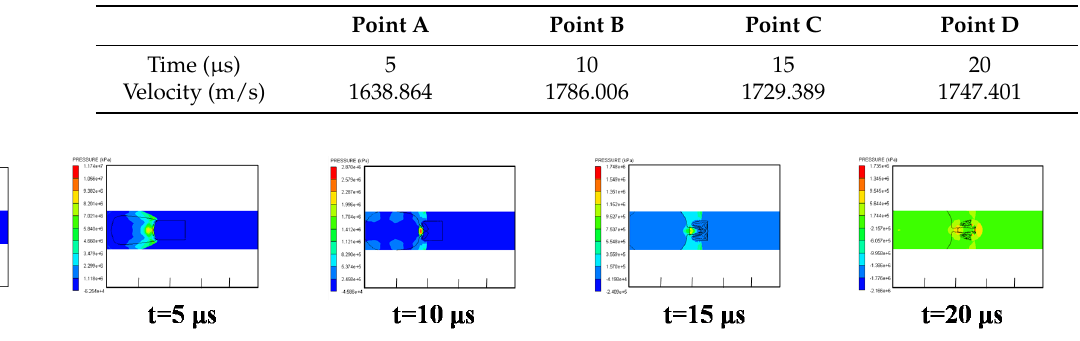
Table 11. Cases discussed in the pit stage.